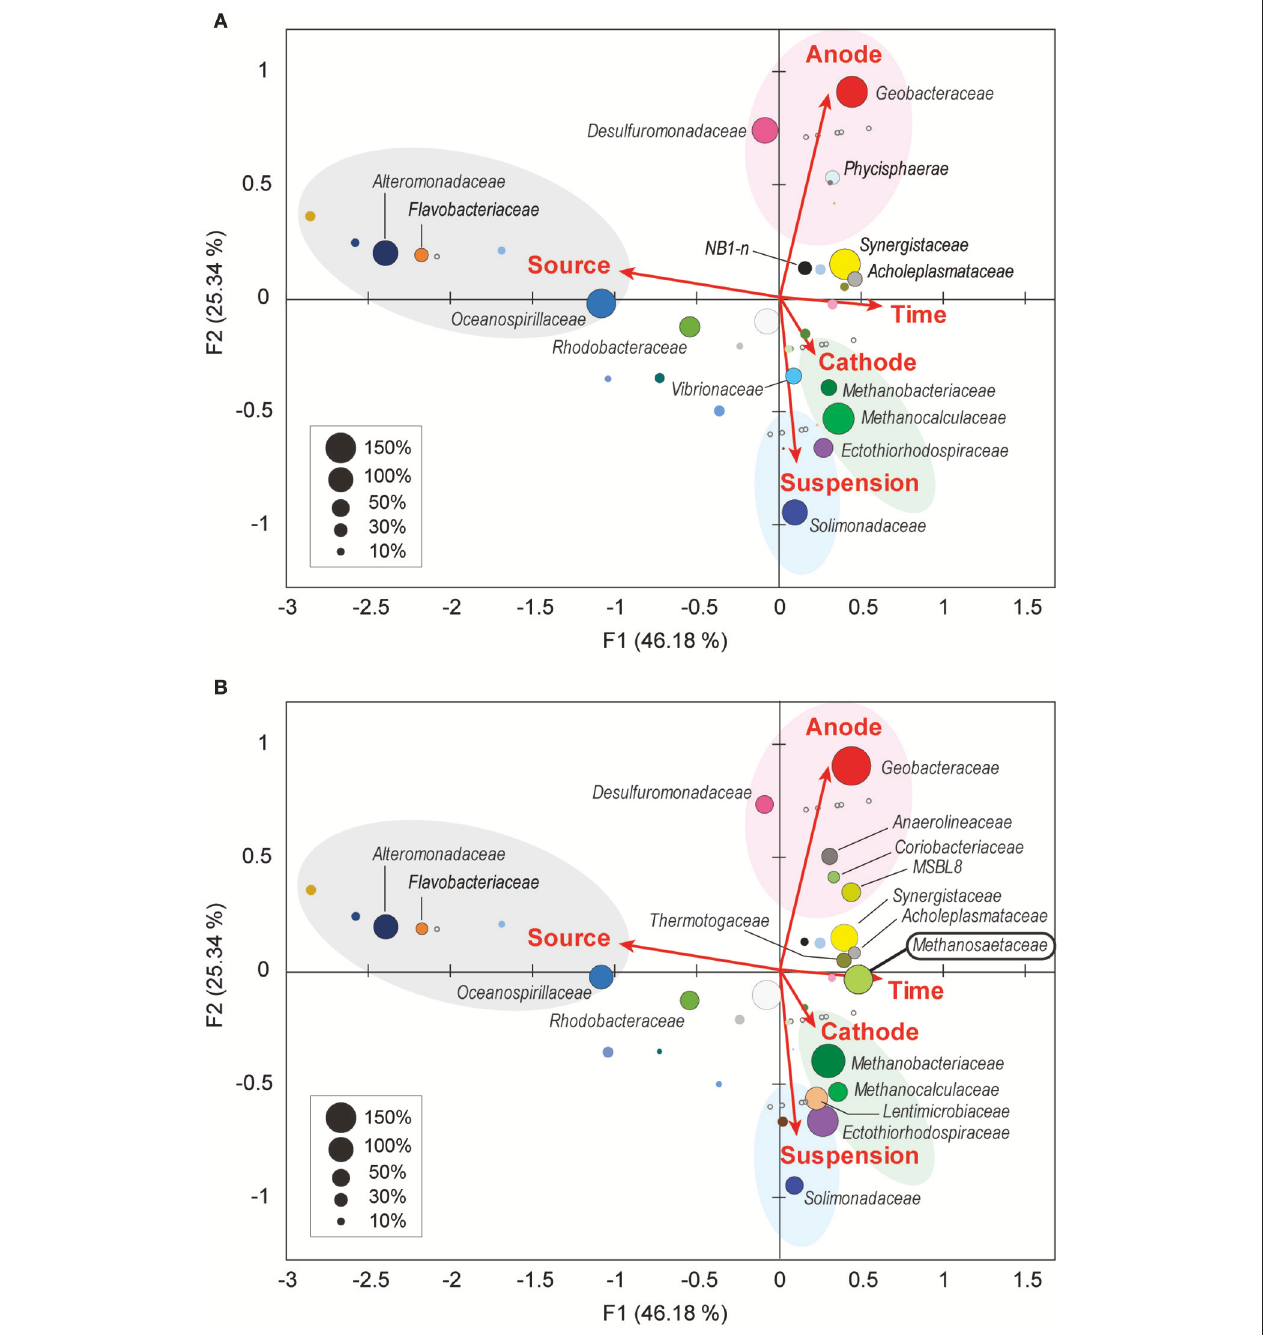
FIGURE 5 | Weighted canonical correspondence analysis (wCCA) diagram correlating microbial taxa and the environmental factors. wCCA diagrams show relationships between operational variables (red arrows) and dominant microbial taxa (filled bubbles) in BES reactor A (A) and reactor B (B) . The bubble colors indicate families that described in Figure 4 . Bubble sizes indicate sum of relative frequencies (%) within the microbial community analyses for each reactor with the inoculated formation waters (maximum 1,500% for reactor A, and 1,800% for reactor B). Family names of the taxa of the abundant members (sum of relative frequencies over 20%) are depicted near bubbles, and the full list of the family names is shown in Supplementary Figure S5 . Gray open circles indicate samples for microbial community analyses.